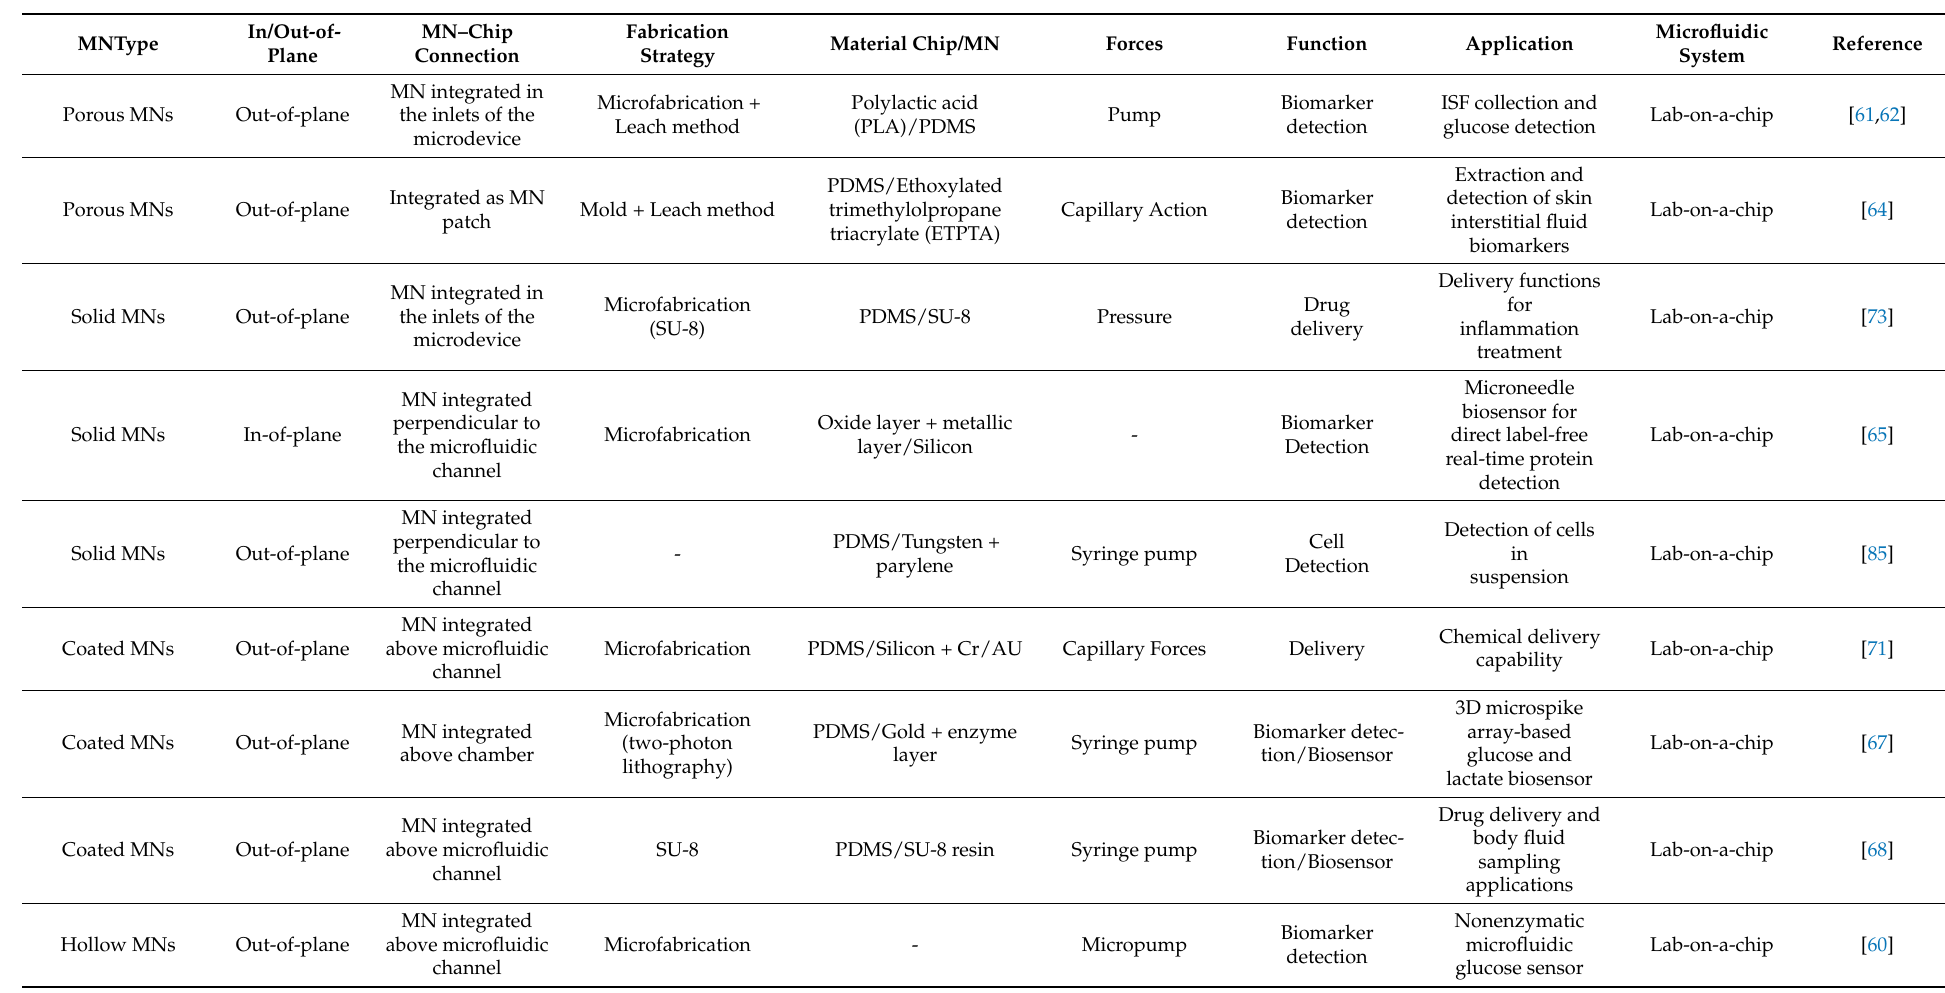
Table 1. Reviewed MNs-based systems concerning MN type, MN–chip connection, fabrication strategy, material, employed hydrodynamic force, function, application and microfluidic